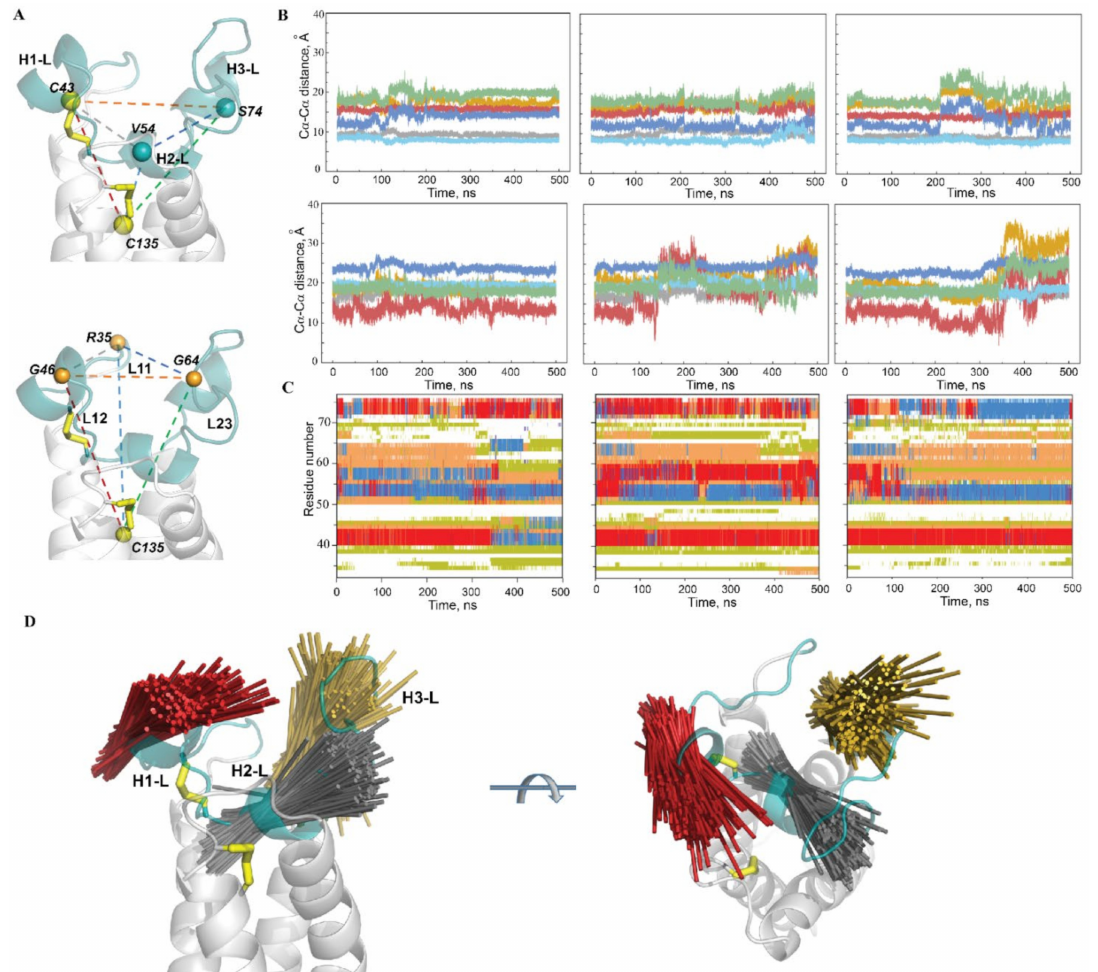
Figure 8. Geometry and folding of the L-loop from hVKORC1 in its inactive state. ( A ) Two tetrahedrons, T1 —defined for the C α -atom of C135 and for the midpoint residues of each L-loop helix, and T2 —defined for the C α -atom of C135 and for the most fluctuating residues (with the greatest RMSF values), from the L-loop linkers. ( B ) Distances between each pair of C α -atoms from the tetrahedrons T1 (top) and T2 (bottom) over each MD trajectory. The distance curves and the edges of a tetrahedron are coloured similarly. ( C ) The time-dependent evolution of the secondary structure of each residue, as assigned by the Define Secondary Structure of Proteins (DSSP) method: α -helix is in red, 3 10 -helix is in blue, turn is in orange and bend is in dark yellow. ( D ) Drift of the L-loop helices observed over the MD simulations (concatenated trajectory, sampled every 100 ps). Superimposed axes of helices from the L-loop are covered on the randomly chosen conformation of hVKORC1 in two orthogonal projections. The axis of each helix is defined as a line connecting the two centroids assigned for the first and the last